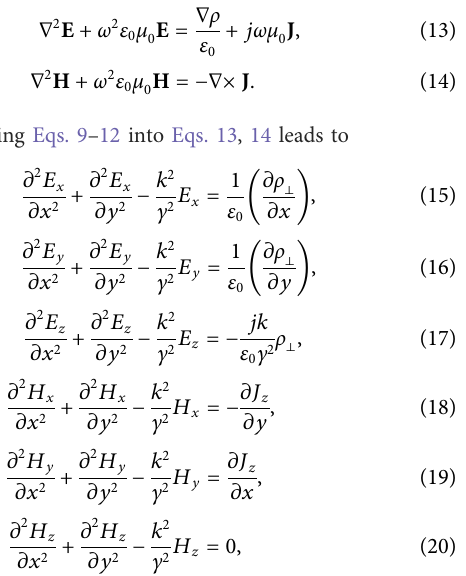
FIGURE 1 A relativistic charged particle beam with transversally Gaussian charge density moving at constant velocity on the axis of an in fi nitely long multilayer vacuum chamber with elliptical cross